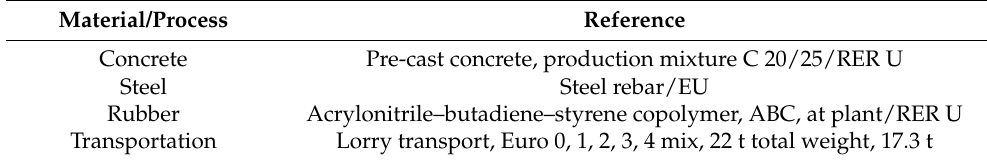
Table 5. Life-cycle inventory (LCI) for Cases 1–3: references from the EcoInvent v3.2 database.